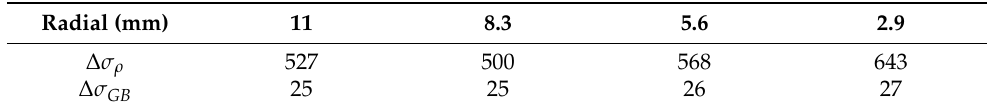
Table 6. The dislocation and grain boundary strengthening of the forged tube with a reduction of 42.7%